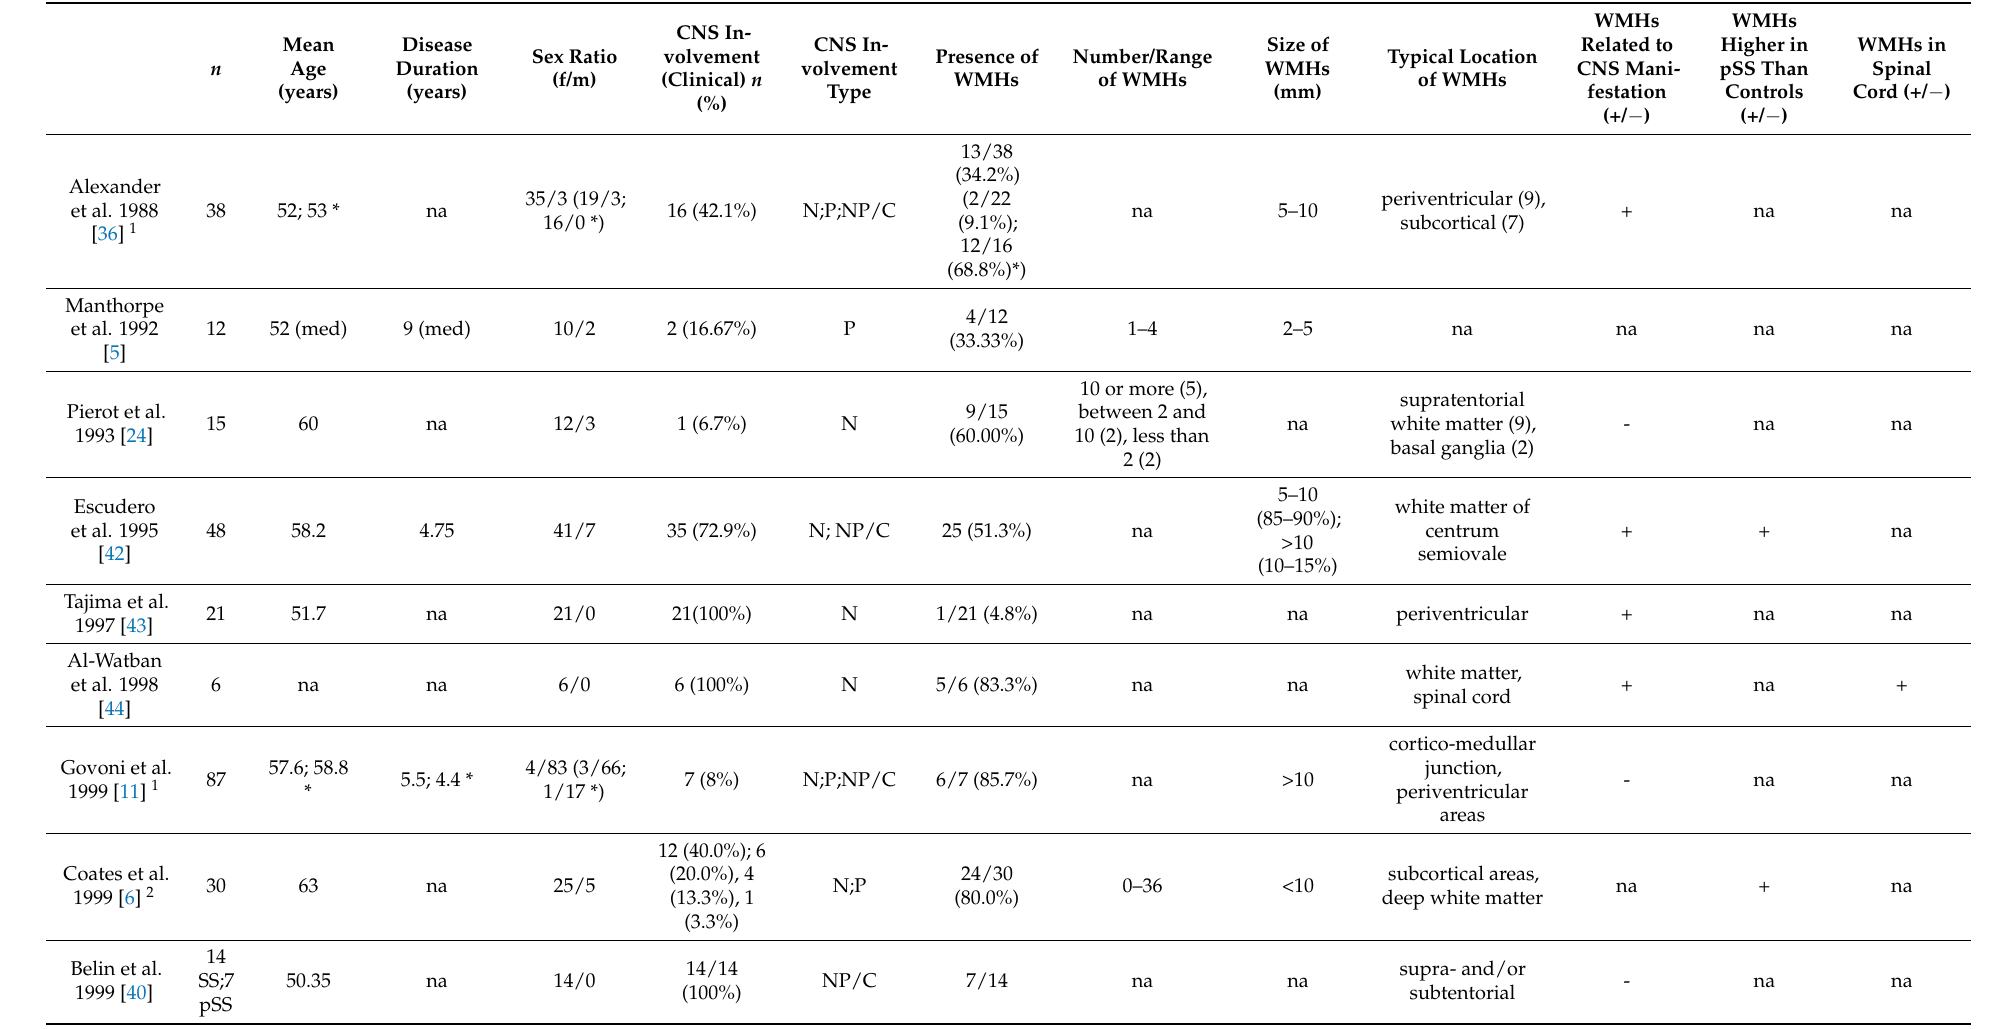
Table 1. Prevalence and properties of WMHs in patients with primary Sjögren’s syndrome. Abbreviations: N: neurological, P: psychiatric, NP/C: